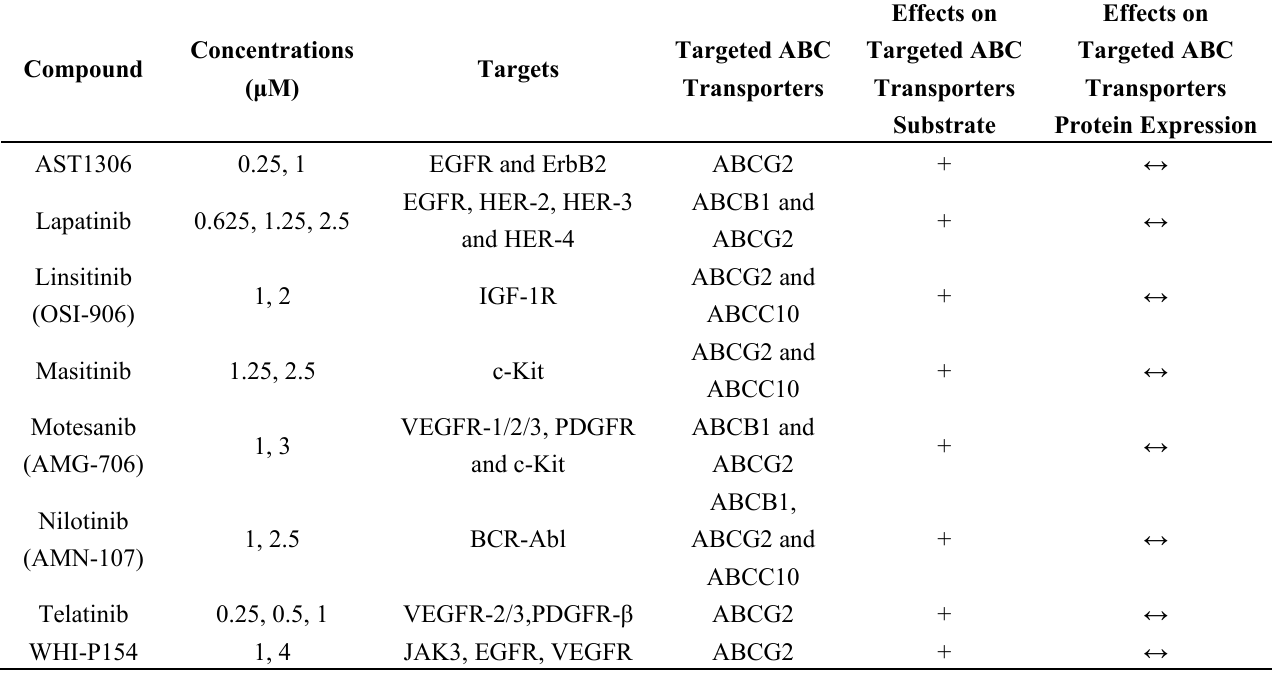
Table 1. Tyrosine kinase inhibitors (TKIs) as modulators of ABC transporter. Concentrations Compound